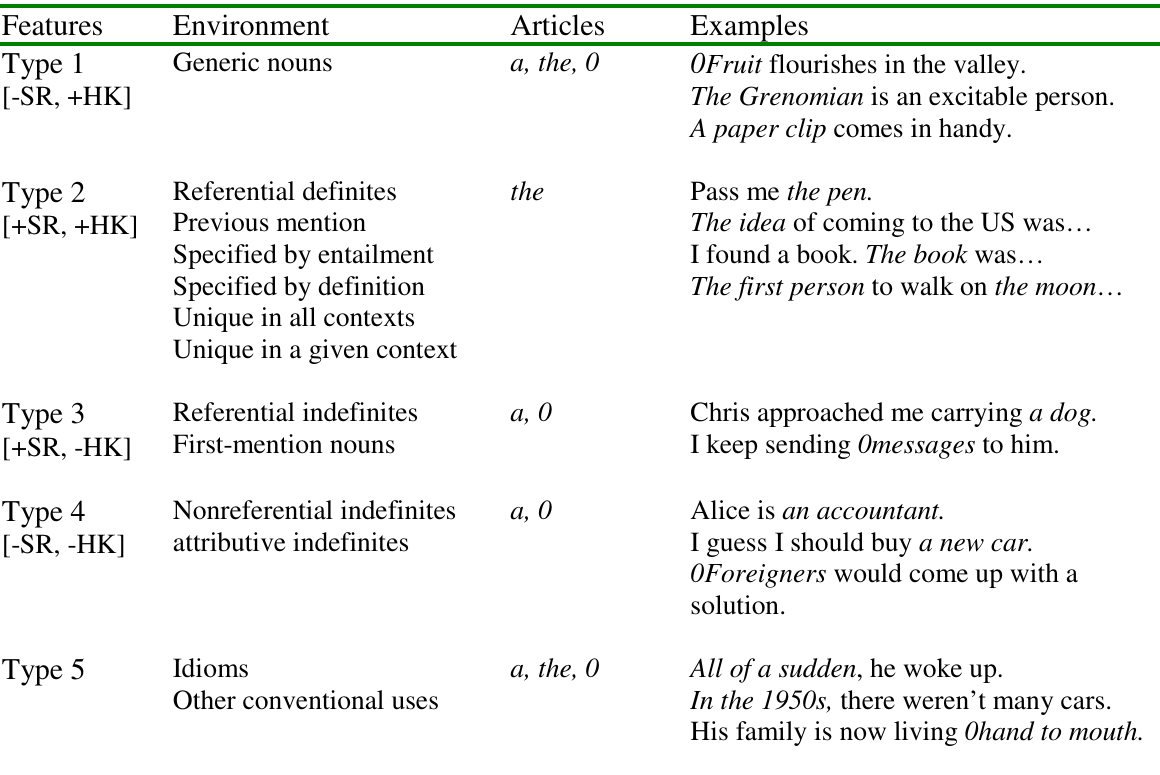
Environments for the Appearance of a, the, and